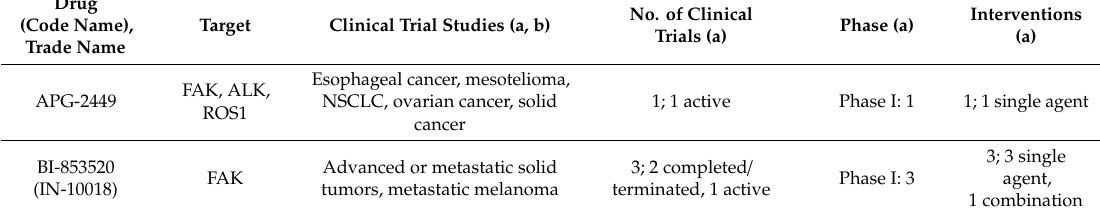
Table 2. Summary of completed, terminated, and active clinical trials with FAK